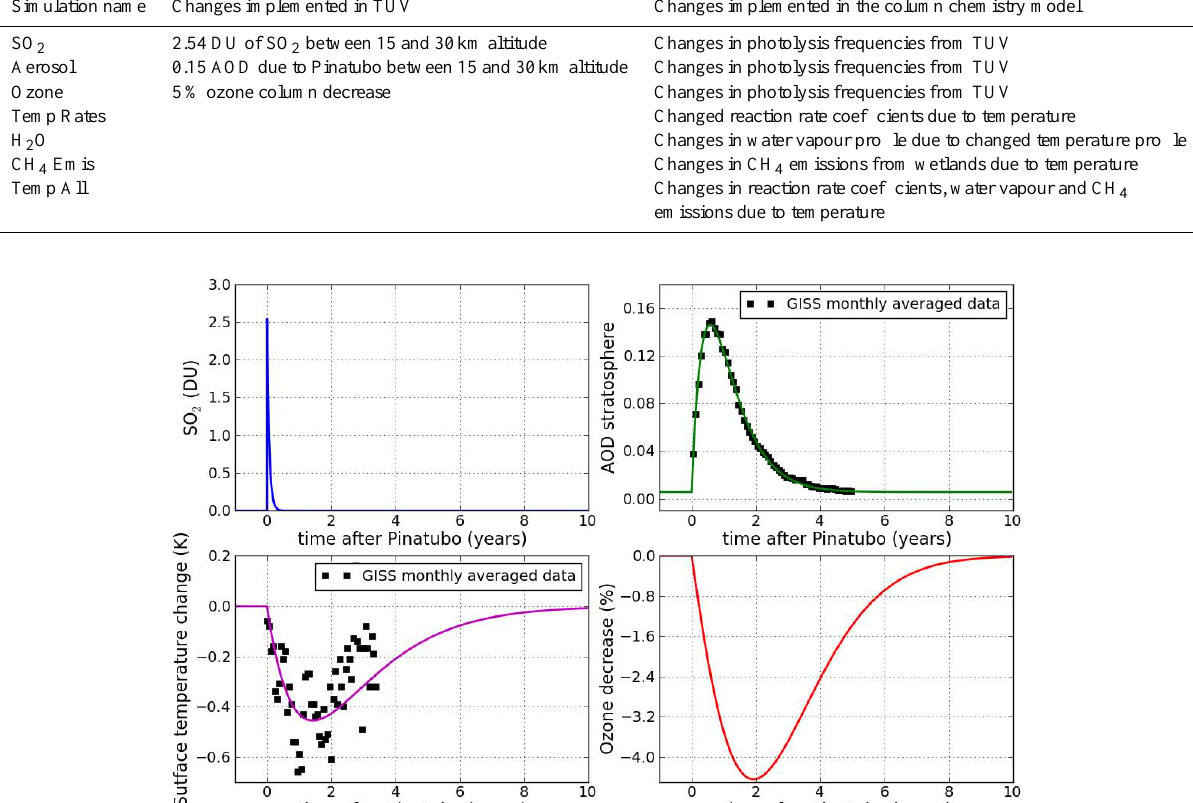
Fig. 1. Time evolution of the forcings, as implemented in the model. Squares represent monthly averaged GISS data (Hansen et al., 2005,